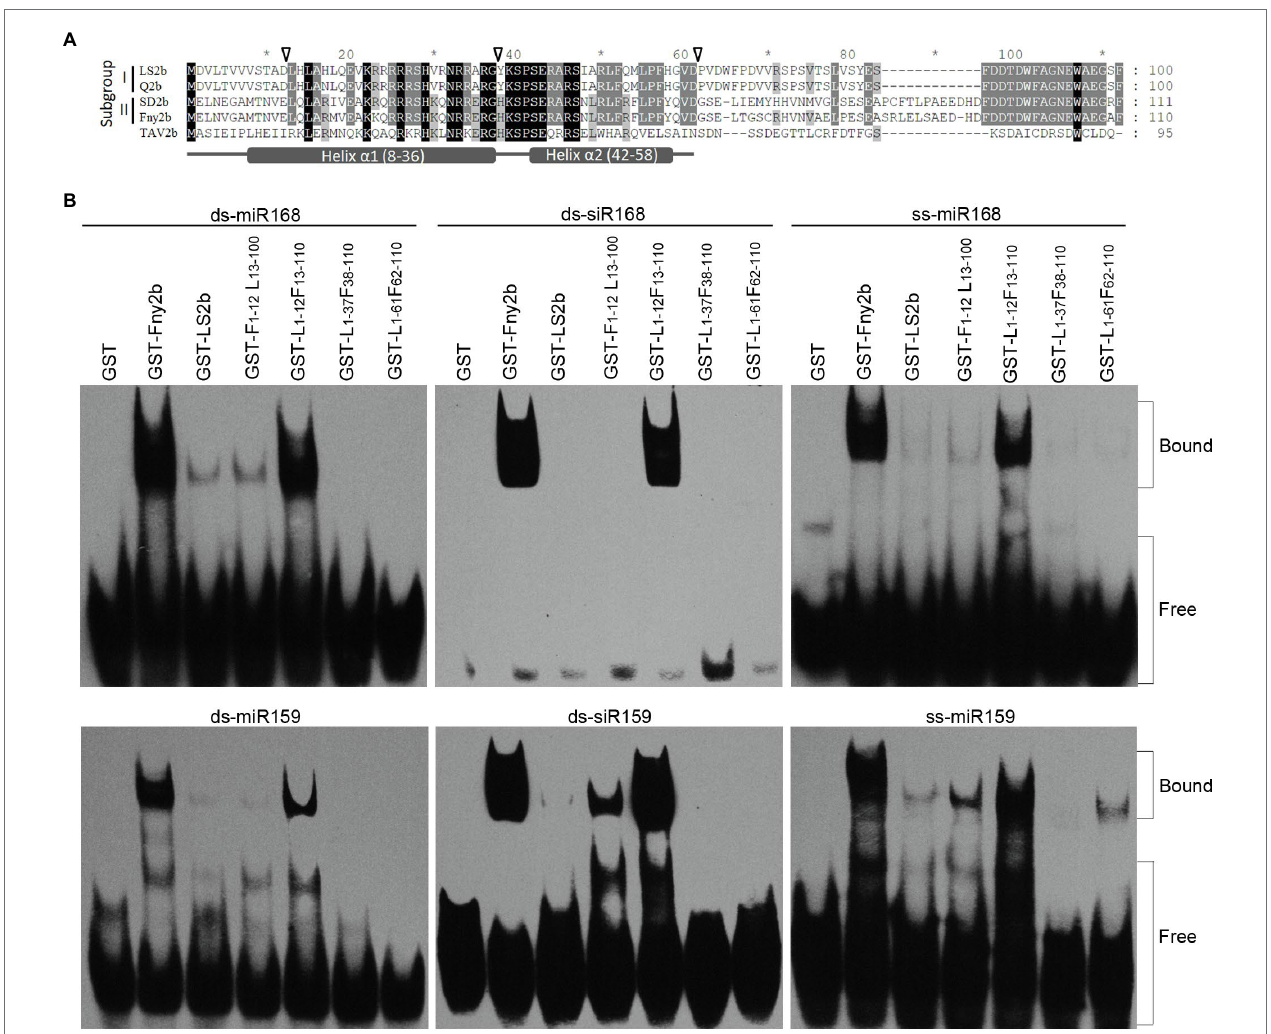
FIGURE 5 | In vitro sRNA binding assay of GST-fused Fny2b, LS2b and their recombinants. (A) Alignment of 2b protein sequences of Subgroups I and II strains of CMV, as well as TAV2b. The arrows shown above the sequences indicate the exchange positions of the 2b recombinants between Fny2b and LS2b. Asterisks (*) shown above the sequences indicate intervals of every 10 residues. Putative helices α 1 and α 2 were shown at the bottom. (B) Electrophoretic mobility shift assays were conducted to assess the relative sRNA-binding ability of the GST-fused 2b proteins. The 2b recombinants were named by the formula F 1-x L y-100 or L 1-x F y-110 , where L and F represent LS2b and Fny2b, respectively, and the lower-cased characters (x and y) represent the exchanging positions in LS2b (L) or Fny2b (F). Arabidopsis miR168 or miR159-derived ss-miRNA, ds-miRNA and ds-siRNA were commercially synthesized and used in the assay as indicated. Biotin-labeled sRNAs were detected using horseradish peroxidase-conjugated streptavidin. The positions of bands corresponding to free and protein-bound RNAs are indicated on the